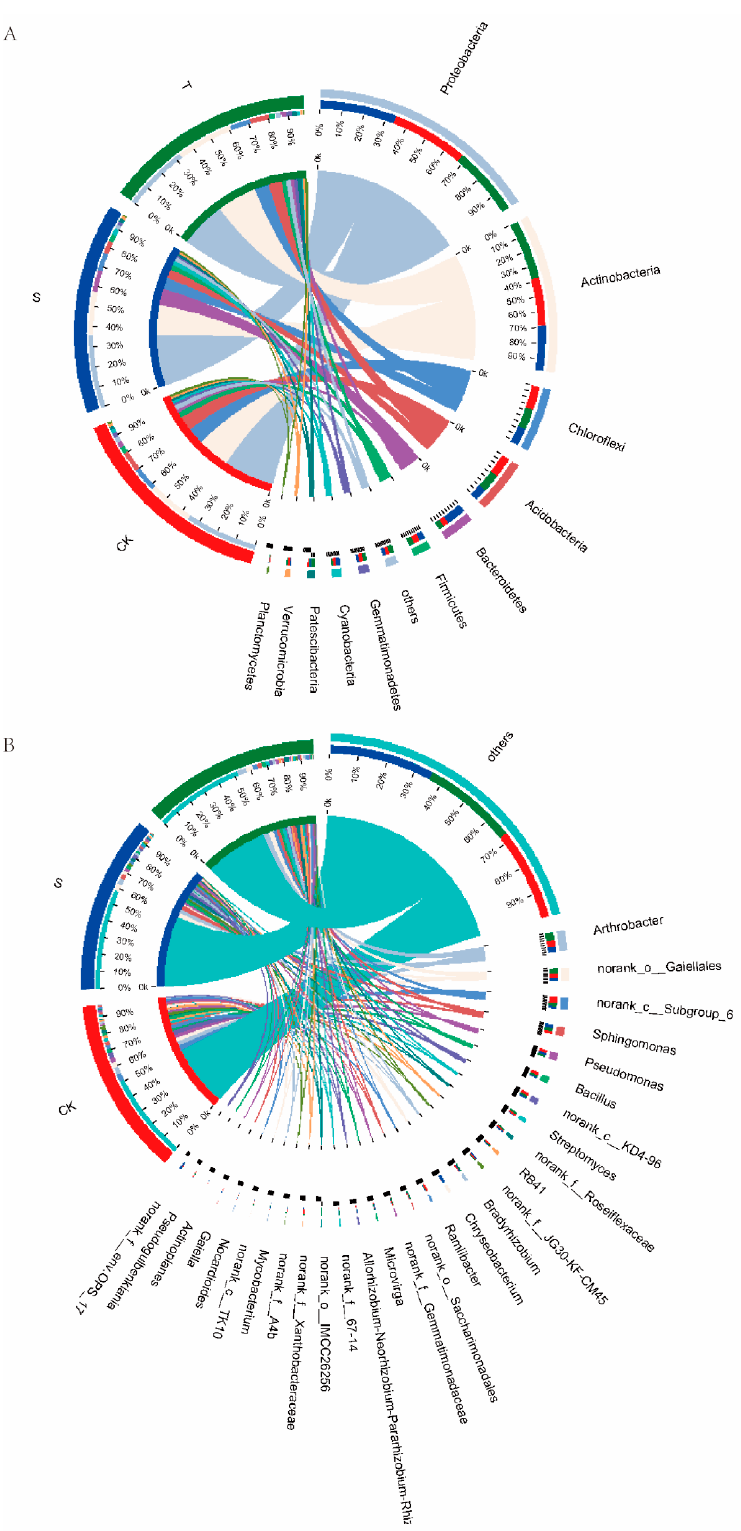
Figure 5. Composition of the bacterial community in tea plantation soils under monoculture and intercropping (soybean–tea plant) systems. Cladogram shows phylogenetic distribution of the most differentially abundant taxa in tea plantation soils under different management at ( A ) phylum and ( B ) genus levels. S, rhizosphere soil of soybean in tea plant/soybean intercropping system; T, rhizosphere soil of tea plants in soybean/tea intercropping; CK, rhizosphere soil of monocultured tea